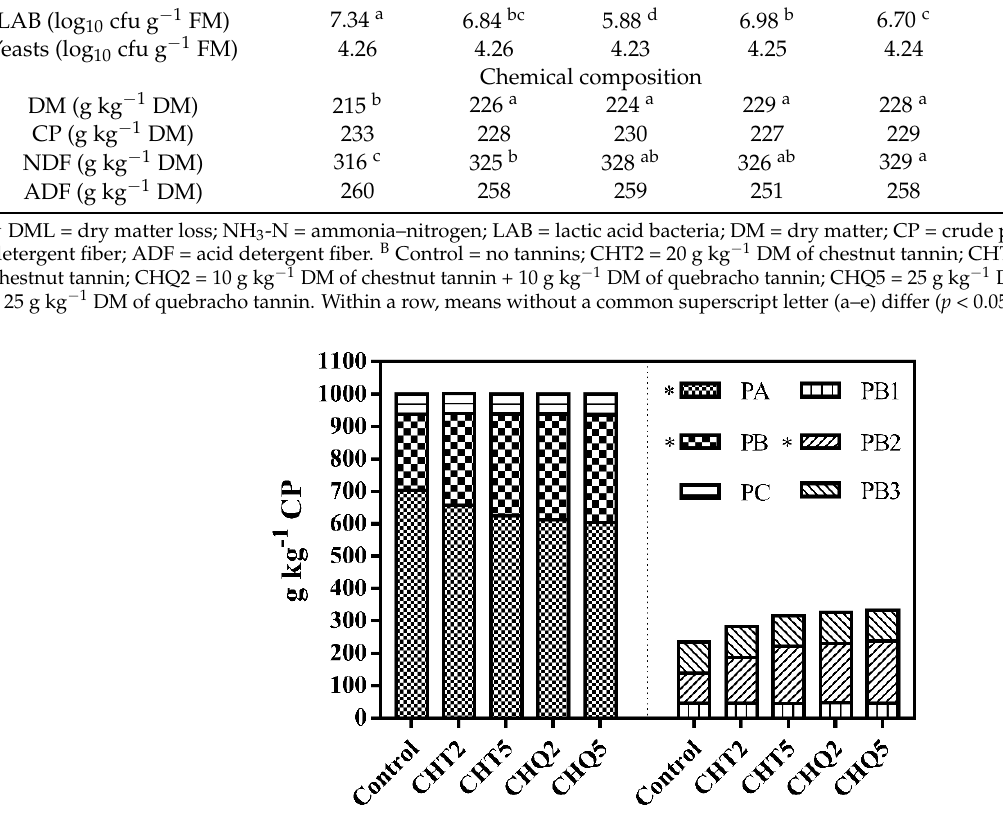
Table 2. Fermentation characteristics, microbial counts, and chemical composition of alfalfa silage treated without or with tannin additives.